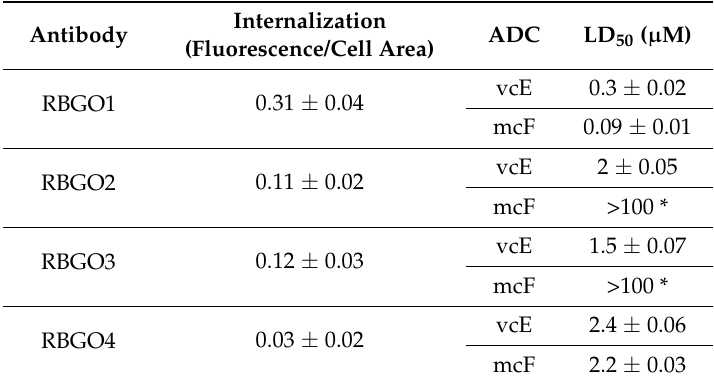
Table 1. Internalization and cell toxicity of Receptor for Advanced Glycation End Products (RAGE) targeting antibody drug